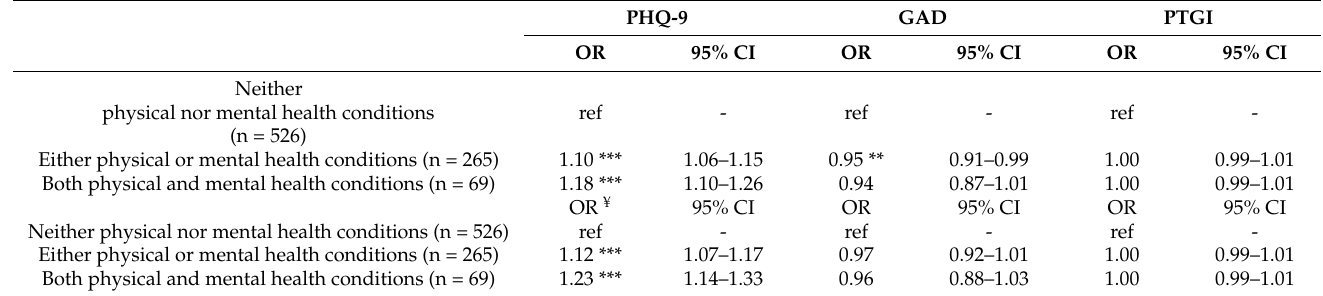
Table 3. Unadjusted and adjusted multinomial regression investigating the relationship of health groups with depression, anxiety, and posttraumatic growth. PHQ-9 GAD PTGI OR 95% CI OR 95% CI OR 95%